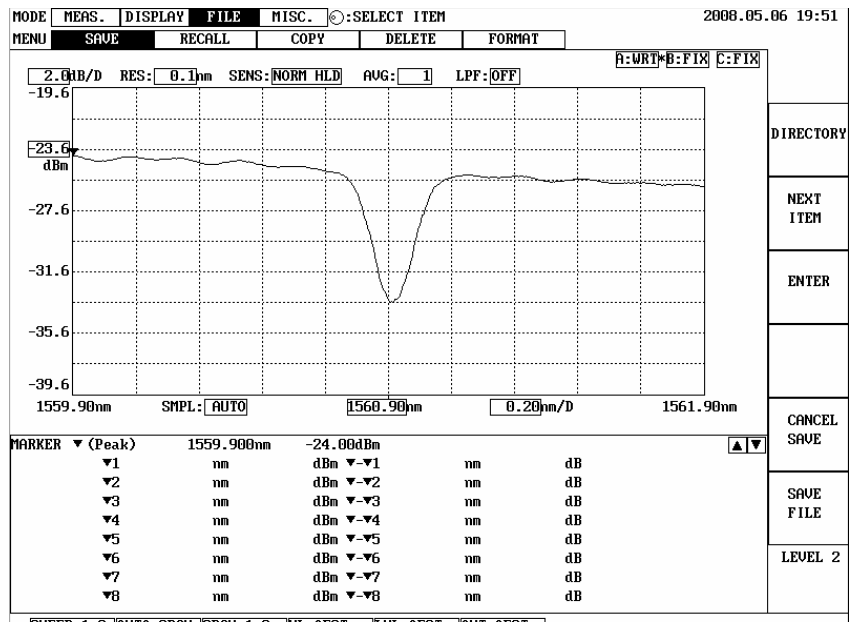
Figure 5. Transmittance spectrum of the FBG filter.